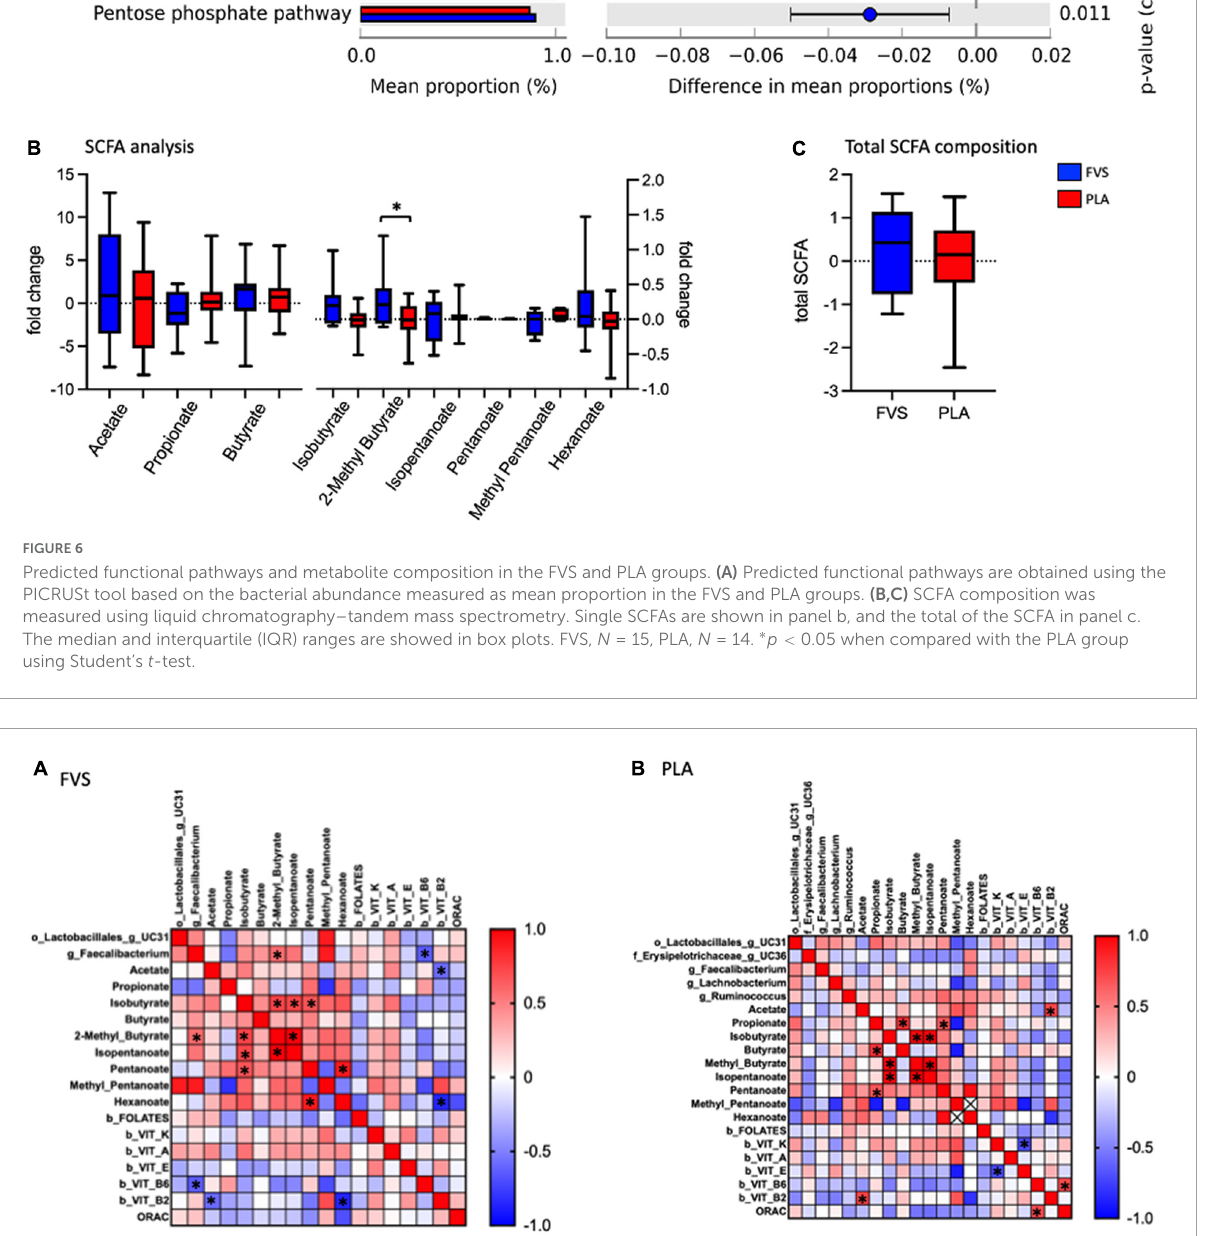
the gut microbiota and SCFA in regulating the antioxidant capacity activated by fruit and vegetable supplementation.